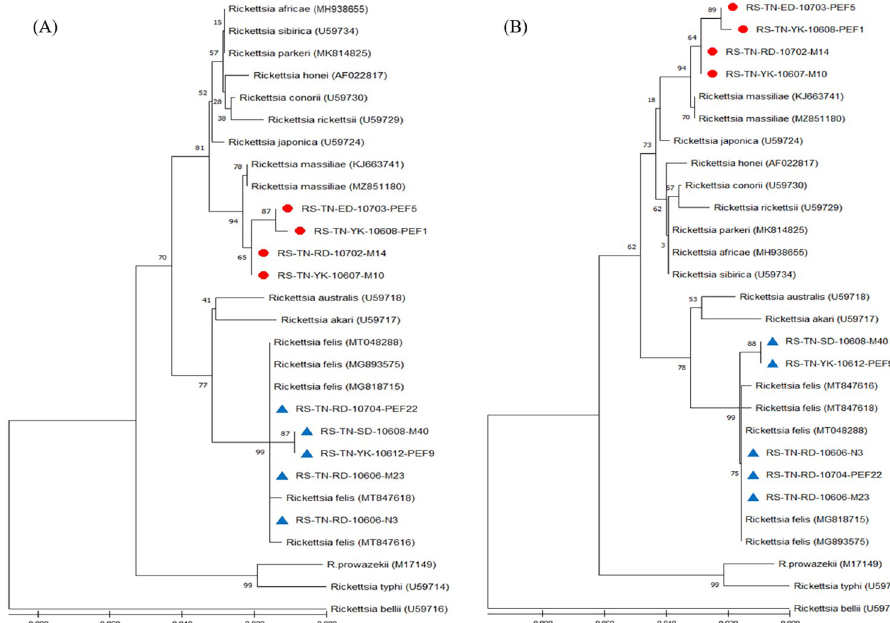
Fig 3. Phylogenetic relationships based on the citrate synthase ( gltA ) gene. Sequences of Rickettsia between 9 specimens (indicated as ● & ▲) detected in Rhipicephalus sanguineus ticks from Tainan City of Taiwan and 19 other Rickettsia specimens identified from various biological and geographical origins. The Tainan strains were genetically affiliated with the R . massiliae (indicated as ●) and R . felis (indicated as ▲), respectively. The trees were constructed and analyzed by (A) neighbour-joining and (B) maximum likelihood methods using 1000 bootstraps replicates. Numbers at the nodes indicate the percentages of reliability of each branch of the tree. Branch length is drawn proportional to the estimated sequence